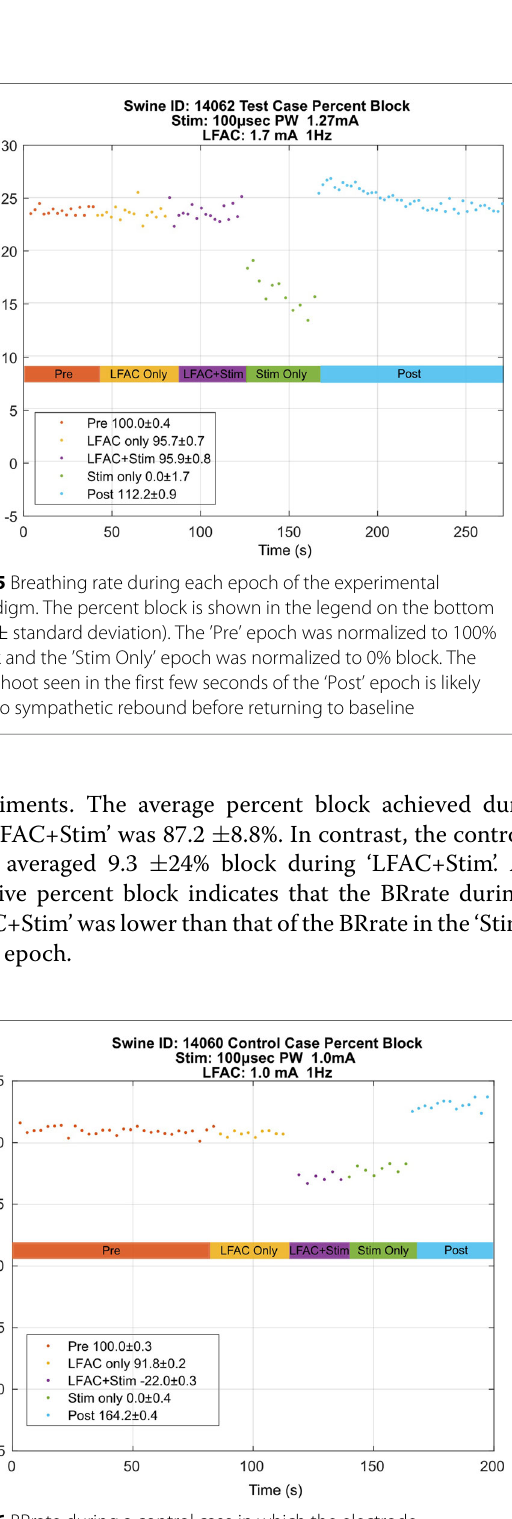
Fig. 6 BRrate during a control case in which the electrode connections were swapped. Vagal stimulation was delivered via the CE and the LFAC waveform was presented at the RE. In this control case, the percent block ( ± SD) during the ’LFAC+Stim’ epoch was calculated to be -22%. A negative percent block indicates that the breathing rate during ’LFAC+Stim’ was lower than the breathing